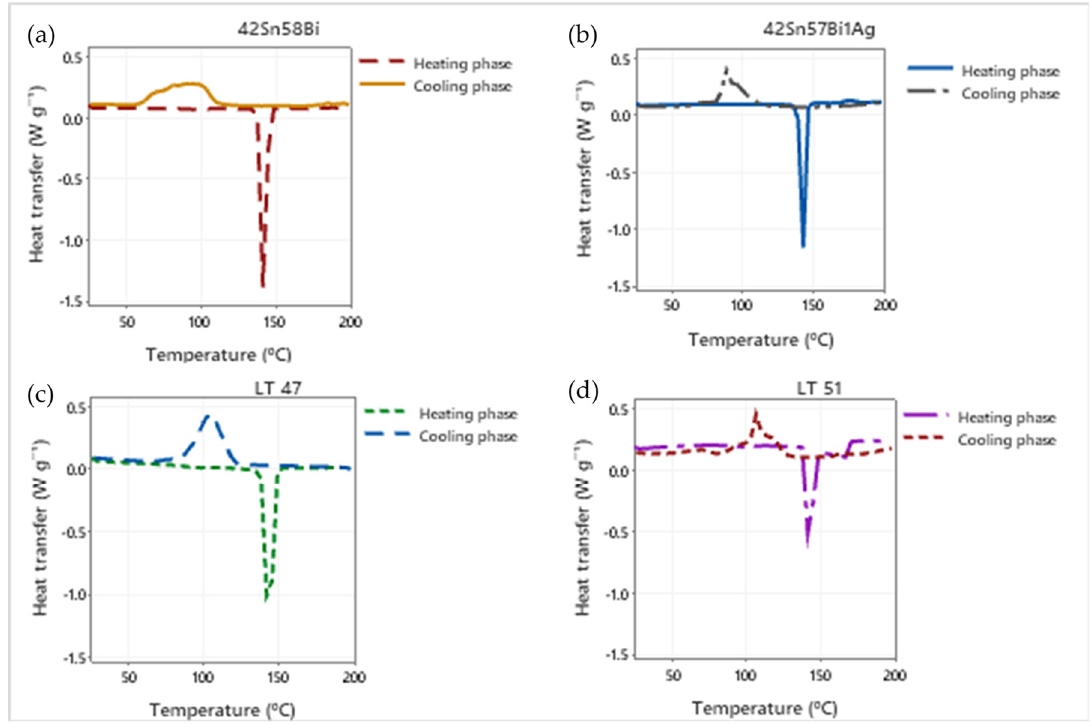
Figure 8. Differential scanning calorimetry (DSC) of for ( a ) 42Sn58Bi, ( b ) 42Sn57Bi1Ag, ( c ) LT 47, ( d ) LT 51.